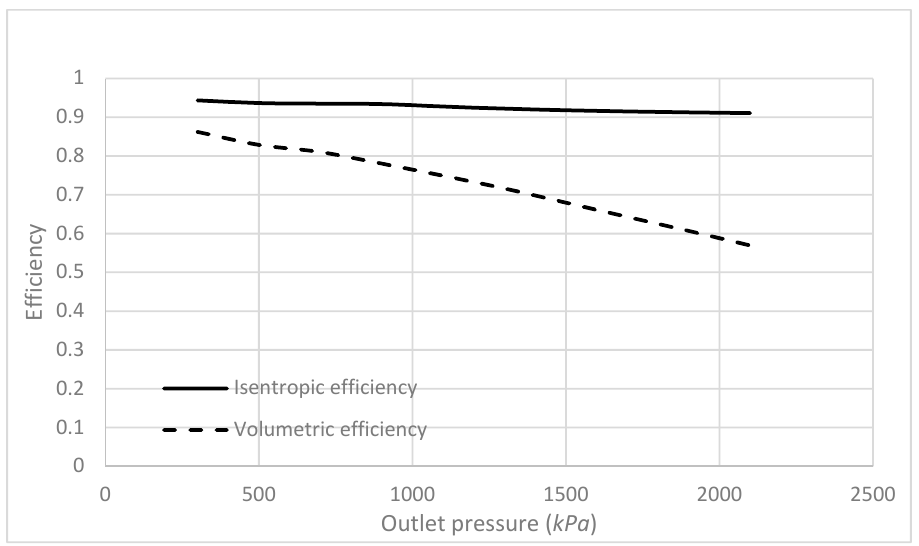
(cid:3042) = 300 kPa ).